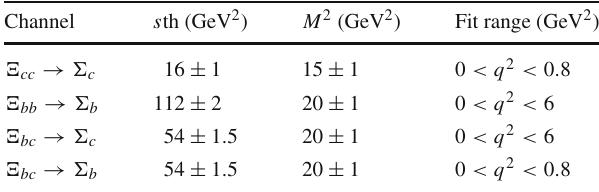
Table 4 Threshold s th of (cid:2) QQ (cid:2) , Borel parameters M 2 , and q 2 range for fitting form factors